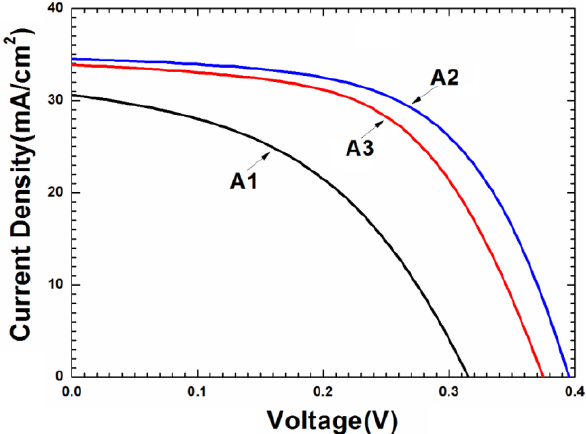
Table 3. Performance parameters of CZTSe solar cells that were prepared by the precursor samples of A1, A2, and A3.